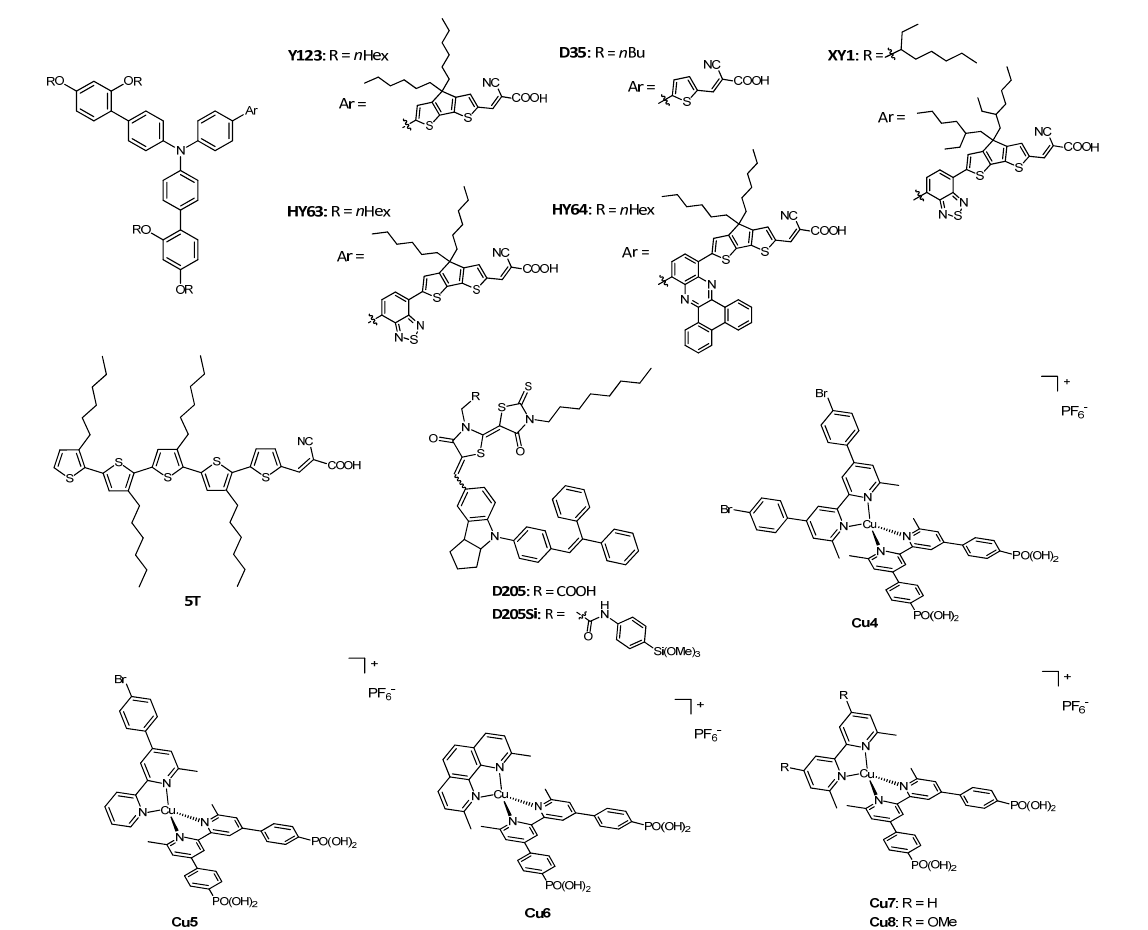
Figure 5. Structure of the dyes used with bipyridine copper-based redox mediators.